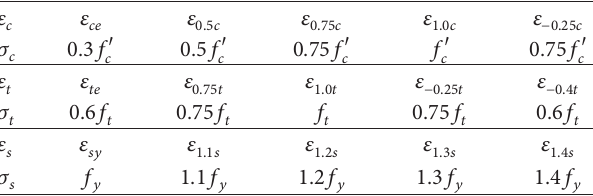
Table 2: The values of corresponding stresses of strain damage indicators at material